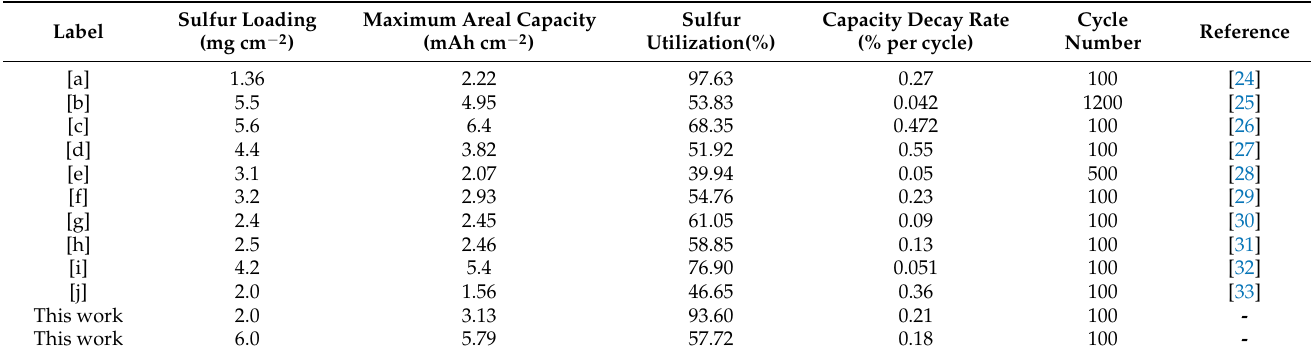
Table 5. Electrochemical performances of present studies with tuning